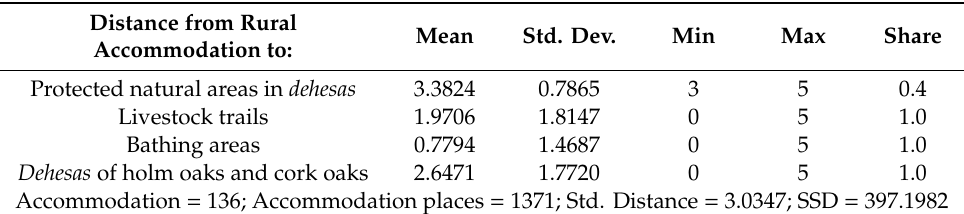
Table 10. Overall variable statistics (Group 3).